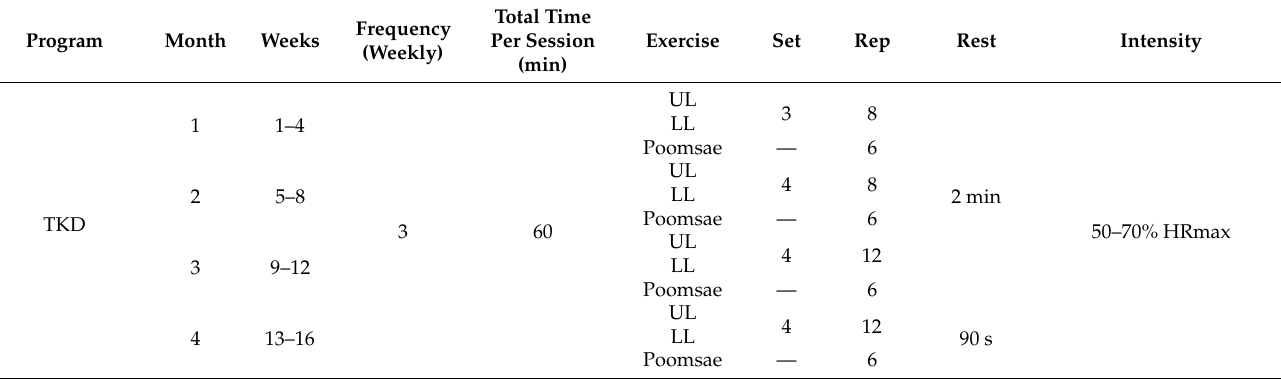
Table 1. Progression for intervention (Training volume and intensity).